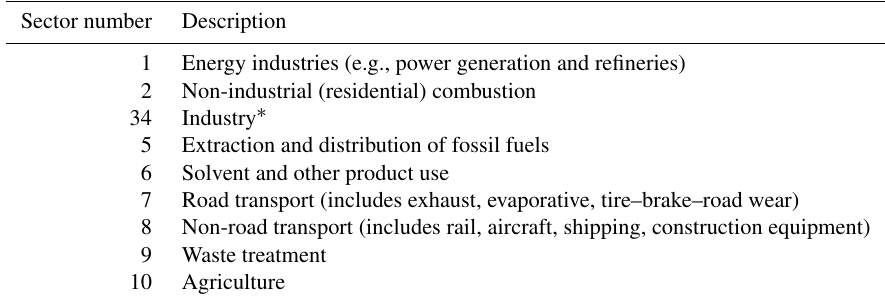
Table 1. SNAP sector classification of anthropogenic emissions. Sector number Description 1 Energy industries (e.g., power generation and refineries) 2 Non-industrial (residential) combustion 34 Industry ∗ 5 Extraction and distribution of fossil fuels 6 Solvent and other product use 7 Road transport (includes exhaust, evaporative, tire–brake–road wear) 8 Non-road transport (includes rail, aircraft, shipping, construction equipment) 9 Waste treatment 10